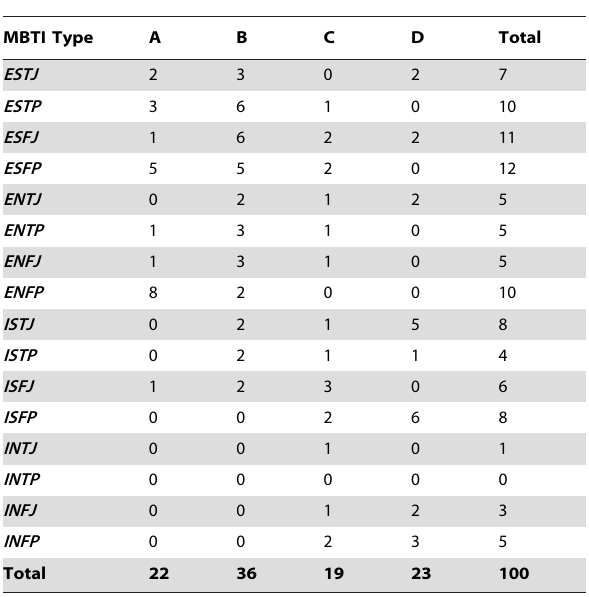
Table 1. Distribution of the 16 different personality types, based on the MBTI Manual, and the observed number of subjects from each posture group (A, B, C, or D) that falls under each personality type.